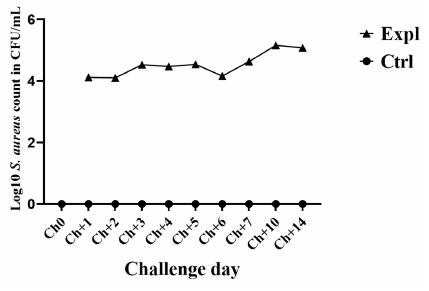
Figure 3. Staphylococcus aureus counts (CFU/mL) from mammary secretion during challenge period. ▲ : Mean of log10 S. aureus count from experimental group, ● : Control group, Ch0: immediately before challenge. Ch+1–Ch+7: days 1 to 7 of challenge. Ch+10 and Ch+14: days 10 and 14 of challenge, respectively. Animals 2020 , 10 , x